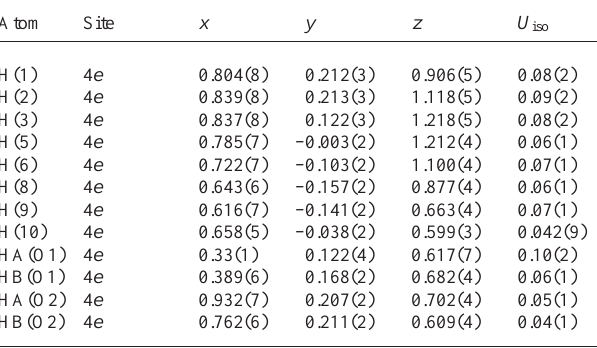
Table 2. Atomic coordinates and displacement parameters (in Å 2 )